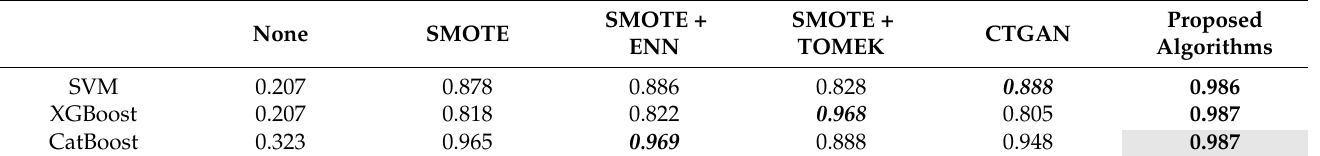
Table 4. F1 score of the classification algorithm according to each data augmentation.